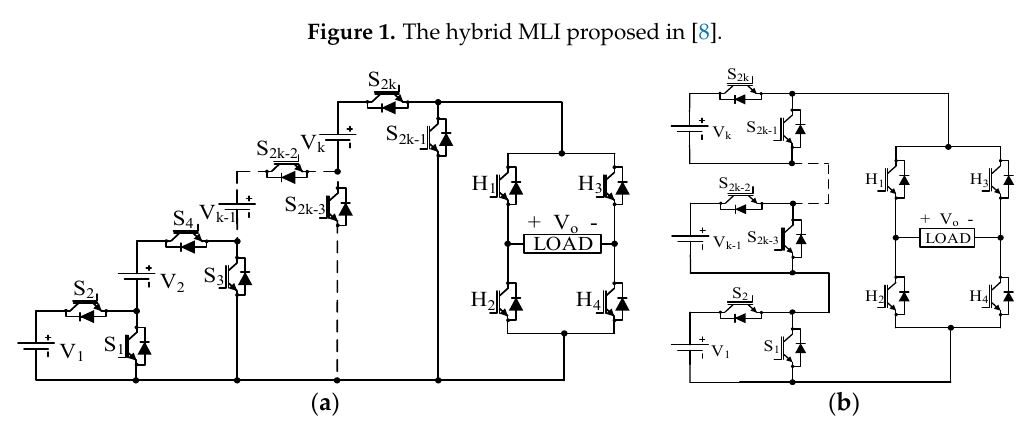
Figure 1. The hybrid MLI proposed in [8].